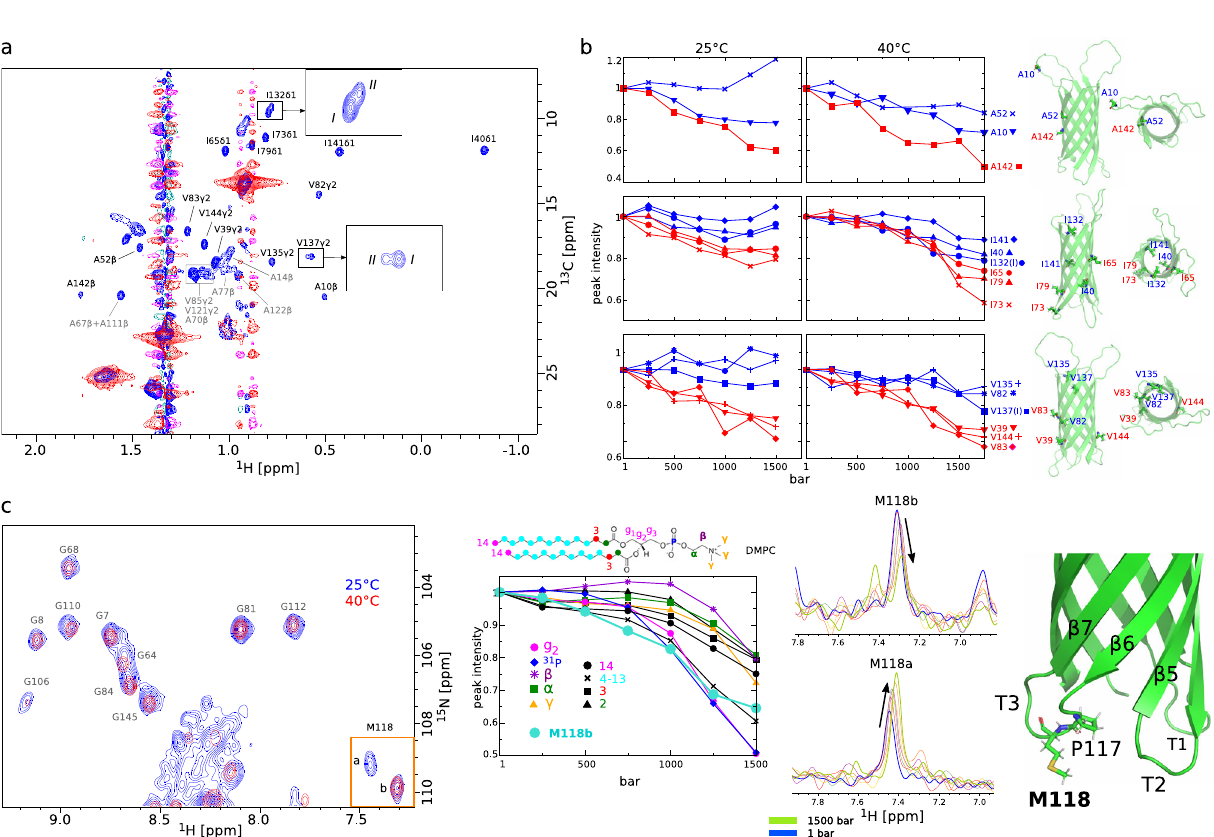
Fig. 5 Barotropic behavior of 13 CH 3 (a,b) and M118 amide 1 H (c) NMR signals of OmpX. a 2D SOFAST-HMQC spectrum (in blue) of perdeuterated OmpX with speci fi c 13 C-labeled and protonated methyl groups in Ala, Ile ( δ 1 ), and Val (proS) residues in protonated DMPC nanodiscs (here at 40°C and atmospheric pressure). The same experiment performed with empty nanodiscs is superimposed in red. In black and gray are OmpX residues that have been taken into consideration and excluded (due to unfavorable chemical shift dispersions), respectively. The close-ups represent an enlargement of I132 and V137 signals. b Barotropic evolution of 13 CH 3 relative intensities at 25°C (left) and 40°C (right) (from top to bottom, Ala, Ile, and Val residues). In red and blue have been distinguished residues whose side-chains point toward the lipid bilayer or the cavity of the barrel, respectively. Beside each panel are a membrane side and extracellular views of a cartoon representation of OmpX NMR structure in nanodiscs with Ala, Ile, and Val residues represented by sticks (pdb ID = 2M06 (NMR structure of OmpX in phospholipid nanodiscs) 24 ). c Barotropic evolution of M118 amide proton a and b conformations at 25°C (see also Fig. S6b). The 2D superimposed 1 H, 15 N experiment collected at 40°C has been shifted to match the glycine signals observed at 25°C to ease the analysis of the barotropic evolution of signals a and b of M118 at 25°C. The diagram represents a comparison of the evolution of lipid NMR signal intensities (from Fig. 2e) with the proportion of signal of peak b vs. peaks a + b of M118. At 1 bar, M118b represents 52.4% of the sum of the intensities a + b (normalized at 1 in the diagram) and 33.8% at 1500 bar ( ≡ 0.645 in the diagram). The sum of the intensities a + b is constant over the pressure range at ±6%. The 1D 1 H superimposed spectra correspond to rows for peaks a and b of M118 extracted from 2D 1 H, 15 N experiments collected at 25°C between 1 and 1500 bar. The cartoon on the right represents the periplasmic edge of the barrel of OmpX and shows in sticks M118 residue. Source data are provided as a Source Data fi le.